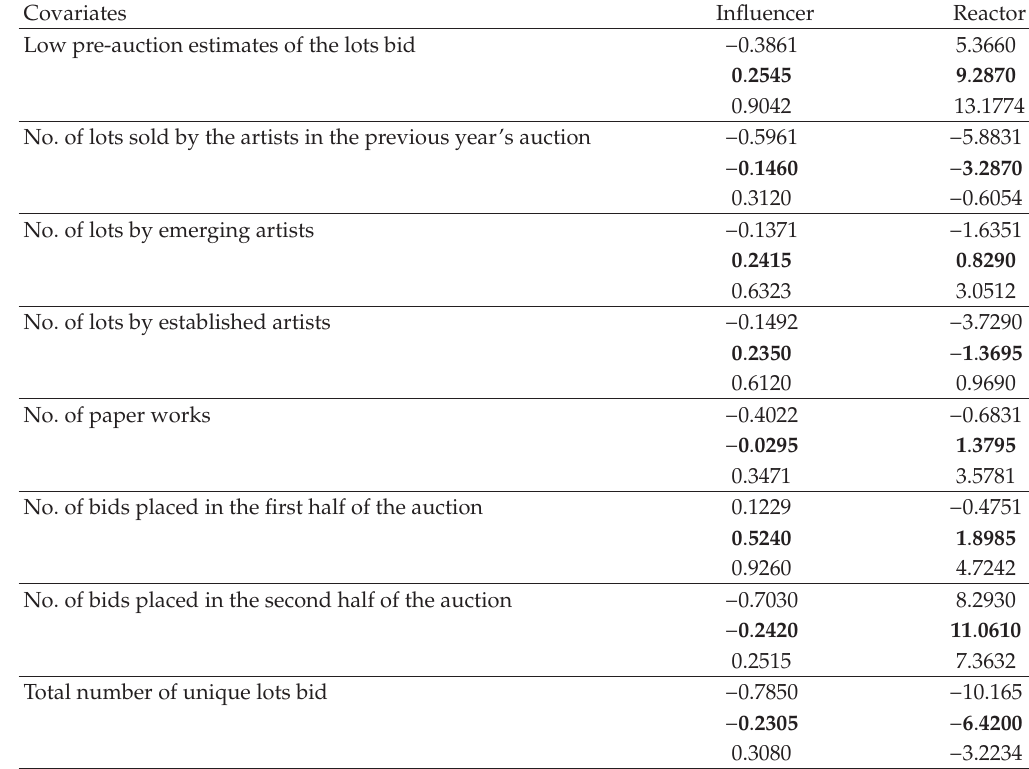
Table 3: Posterior Means and Quantile-Based 95% Confidence Interval for Influencer and Reactor Level